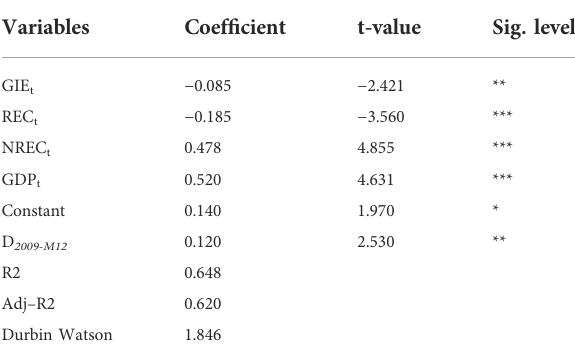
TABLE 3 Results of BARDL (long run) co-integration